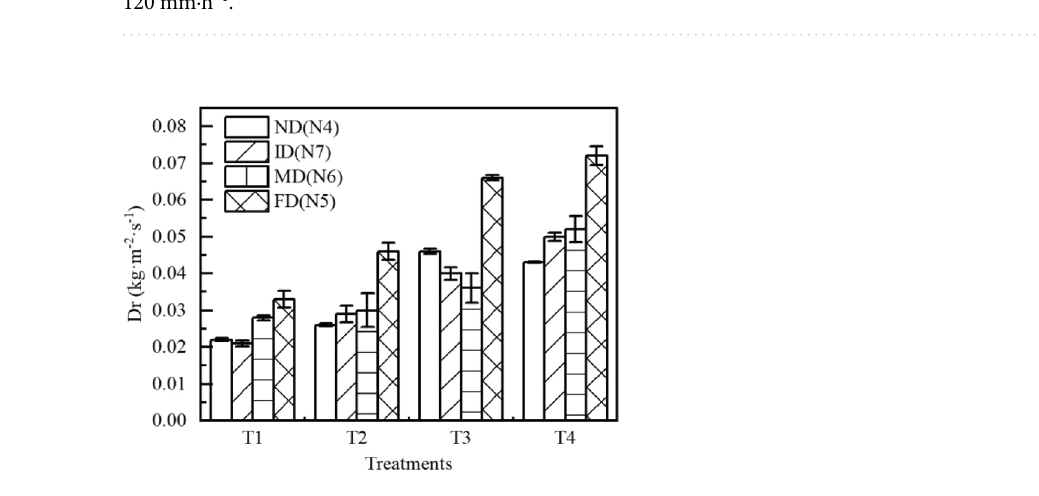
Figure 8. Comparison of soil separation rate D r between four litter decomposition stages. D r is the rate of soil separation; N1–N7 are treatments, see Table 2 for treatment specifics; T1 is slope 5°, rain intensity 60 mm·h −1 ; T2 is slope 10°, rain intensity 60 mm·h −1 ; T3 is slope 5°, rain intensity 120 mm·h −1 ; T4 is slope 10°, rain intensity 120 mm·h −1 . ND is non-decomposed state, ID is initial stage of litter decomposition, MD is middle stage of litter decomposition, FD is final stage of litter